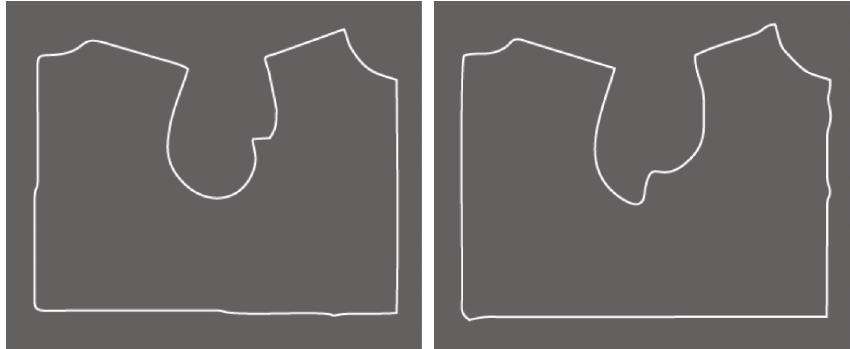
Figure 2: Skeleton.